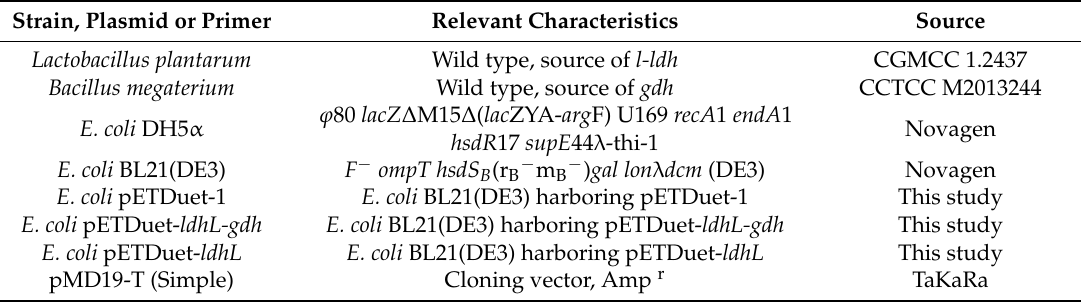
Table 2. Strains, plasmids and primers used in this